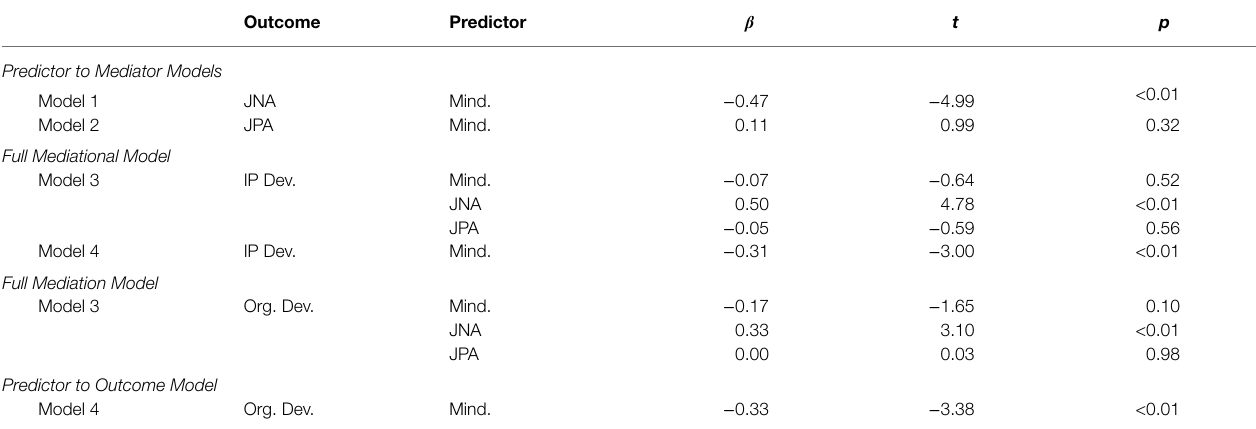
Outcome Predictor β t p Predictor to Mediator Models Model 1 JNA